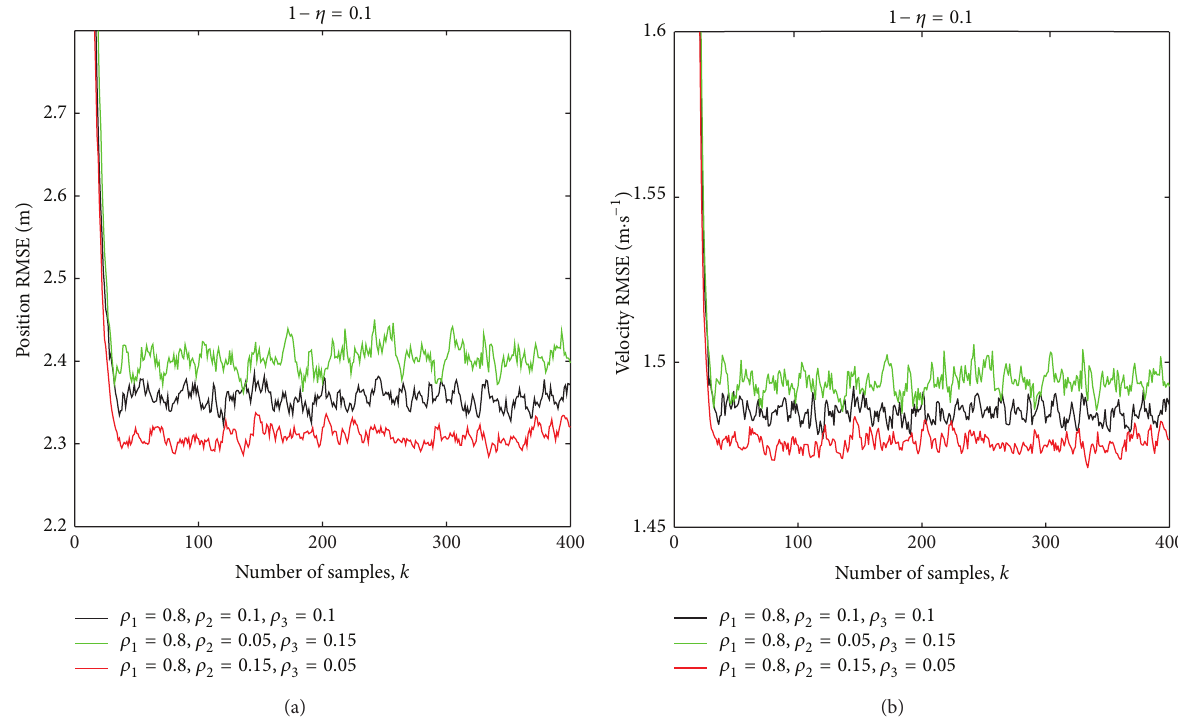
Figure 2: Comparison of the RMSEs for the proposed algorithm with different 𝜌 𝑞 (𝑞 = 1, 2, 3) : (a) position RMSE; (b) velocity RMSE.